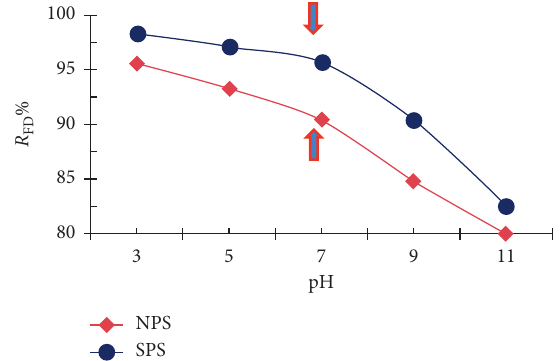
Figure 7: Percentage of removal of FD as a function of the pH solution (1g adsorbent dosage; 10mg/L FD concentration; 50ml solution volume; and 25 ° C temperature).